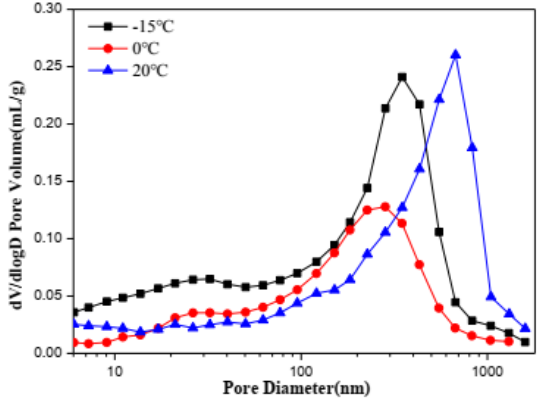
Figure 8. Pore size distribution of samples hydrated for 28 days.